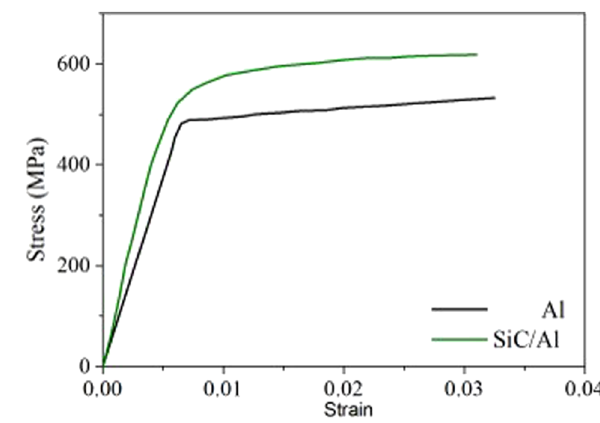
Figure 2: Tensile stress – strain curves of Al and SiC/Al [ 29